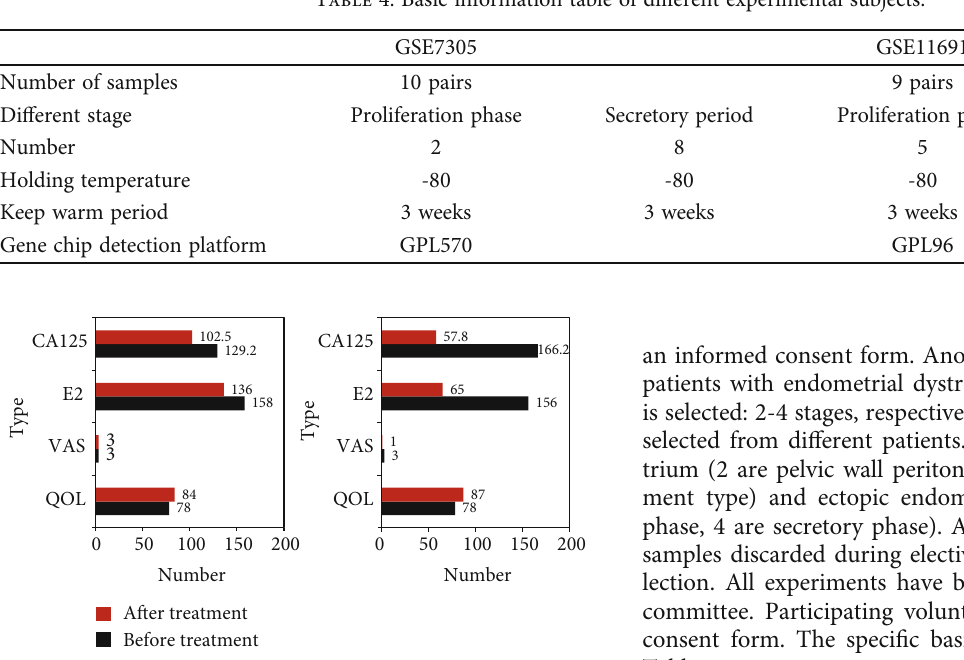
Table 4: Basic information table of di ff erent experimental subjects.